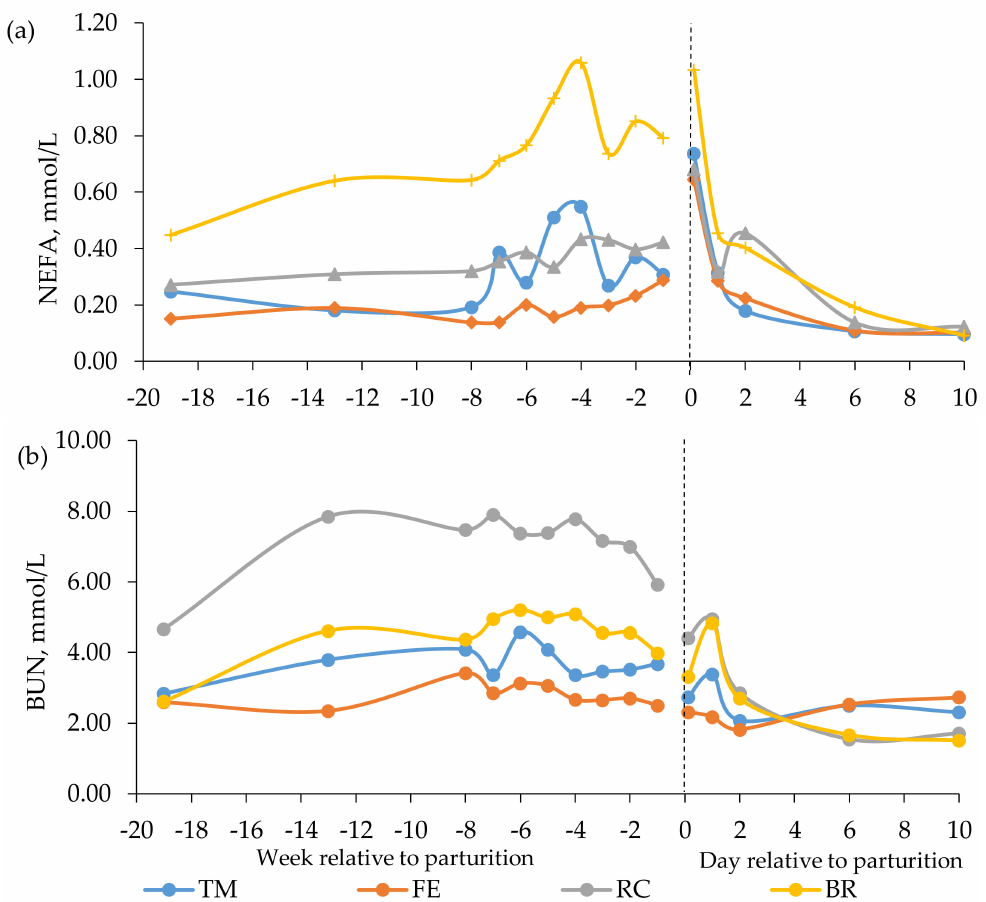
Figure 3. Blood concentrations of ( a ) non-esterified fatty acids (NEFA) and ( b ) blood urea nitrogen (BUN) in beef cows fed timothy-meadow fescue silage (TM), festulolium silage plus urea mix (FE), reed canarygrass silage (RC), or barley straw plus urea mix (BR) ad libitum prepartum, including additional supplementation of rapeseed meal for cows on the BR diet. All cows received the same timothy grass silage ad libitum postpartum. Week -19 prepartum indicates the zero value (sampled prior to initiation of the prepartum experimental treatments). The dashed line indicates time of calving (week 0). Blood was sampled within 3 h ( ± 4.1) of parturition, at 24 h ( ± 4.7) and 48 h ( ± 2.9), and on day 6 and